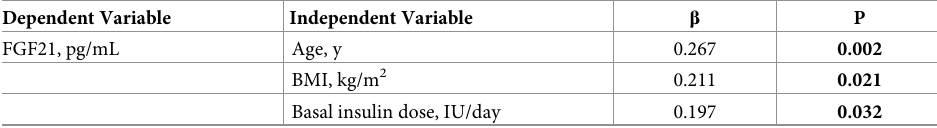
Table 4. Stepwise multiple linear regression analysis of FGF21 in type 1 diabetes